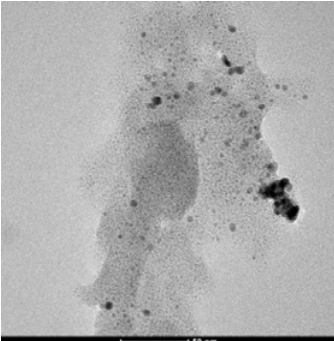
Figure 6. TEM micrograph of G4 25Ac30Im